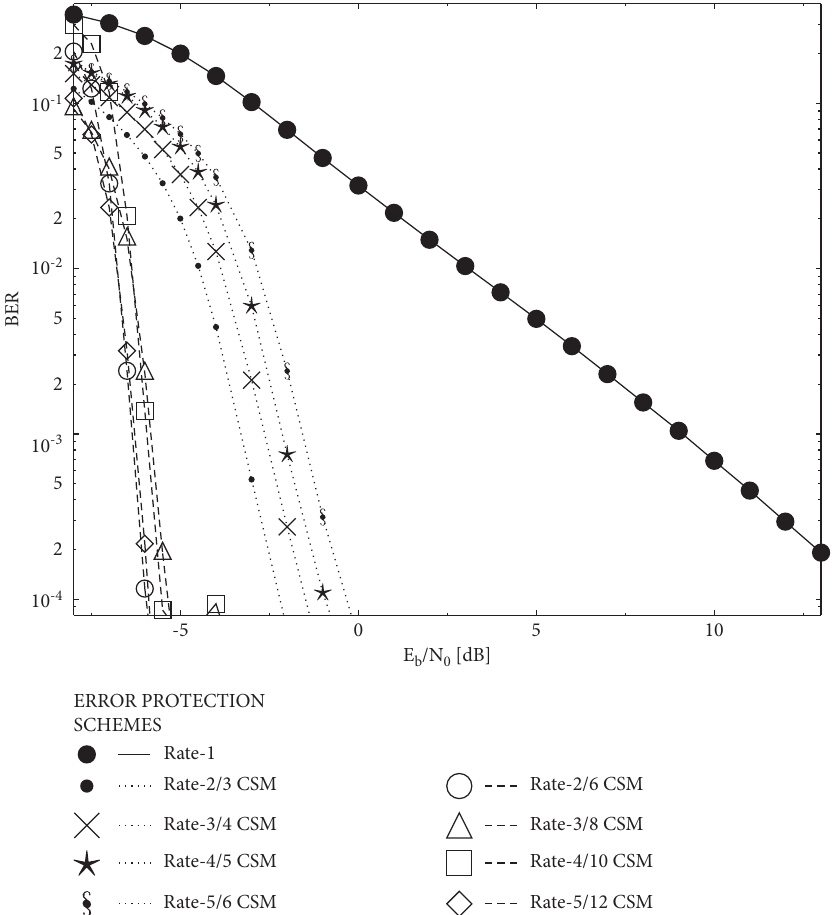
Figure 13: BER performance comparison of CSM schemes with Rate-1